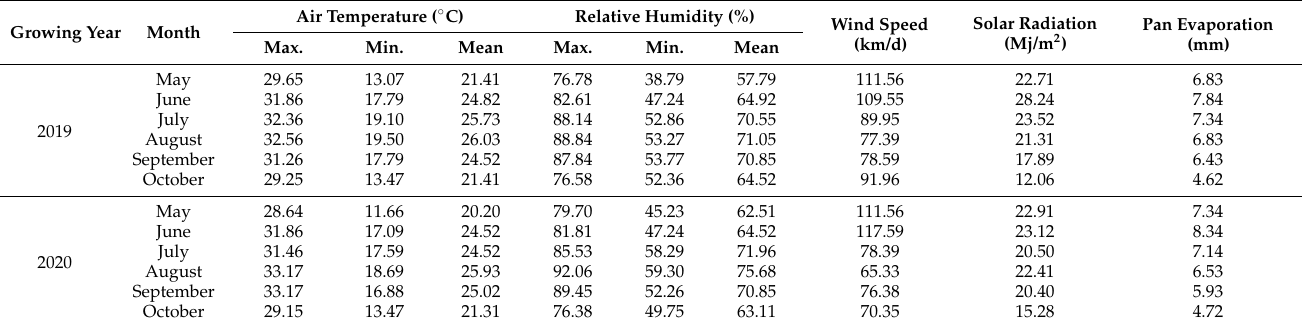
Table 3. Average weather conditions for experimental period during growing